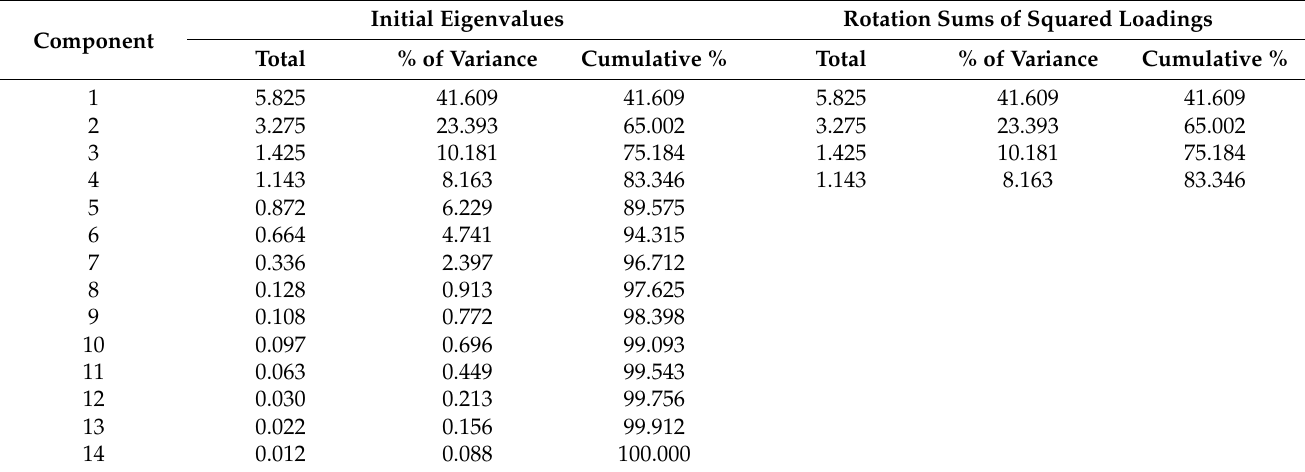
Table 4. Total variance explained (extraction method: principal component analysis).